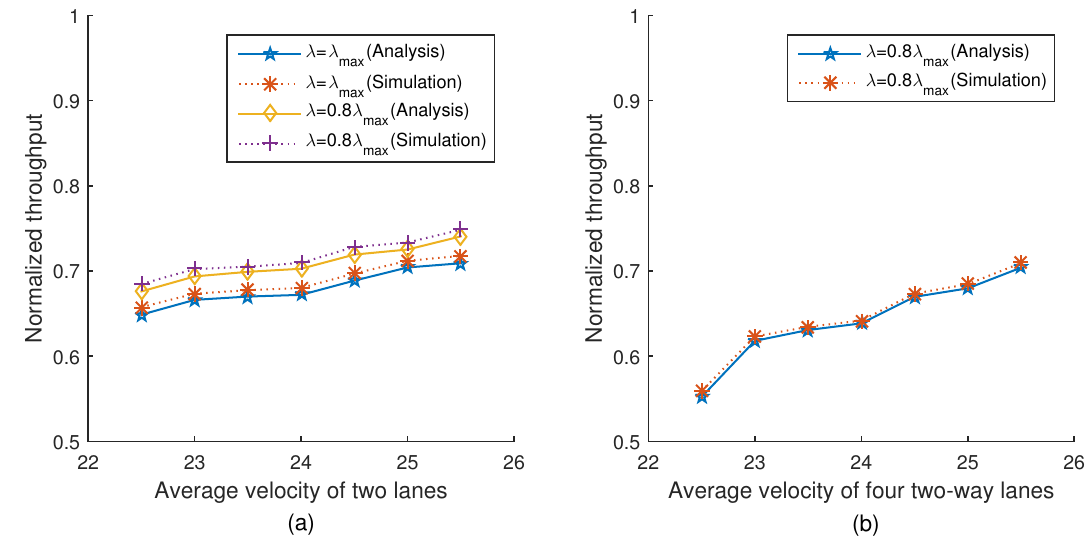
Figure 13. Normalized throughput versus